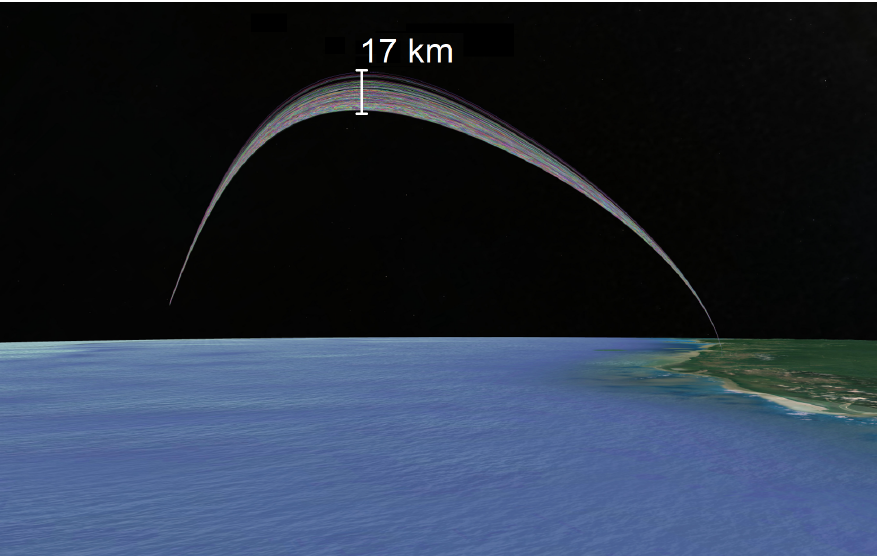
Figure 13. Visualization of the launch vehicle ascent trajectories in 3D due to the uncertain input vector. To evaluate the uncertainty on the 99% quantile estimation, N GP = 150 GP trajectories are sampled and β = 0.025 is used to define the upper and lower bounds on the quantile estimates in the set Q N . Figure 14 presents the scaled KL models for the centered altitude. GP